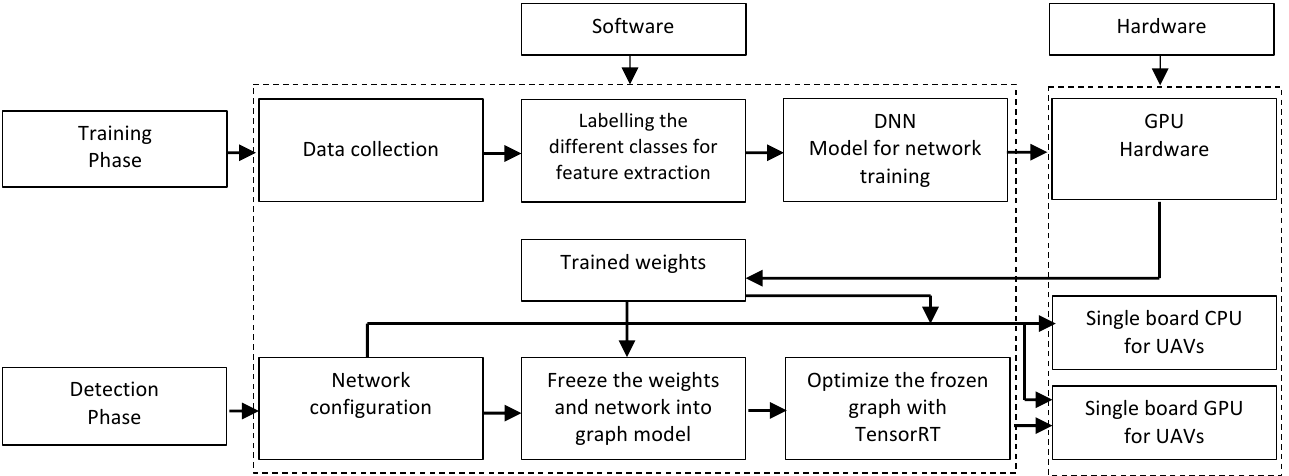
Figure 3. Proposed architecture for UAVs based on-board inspection and an autonomous vision system (Adapted from ref.